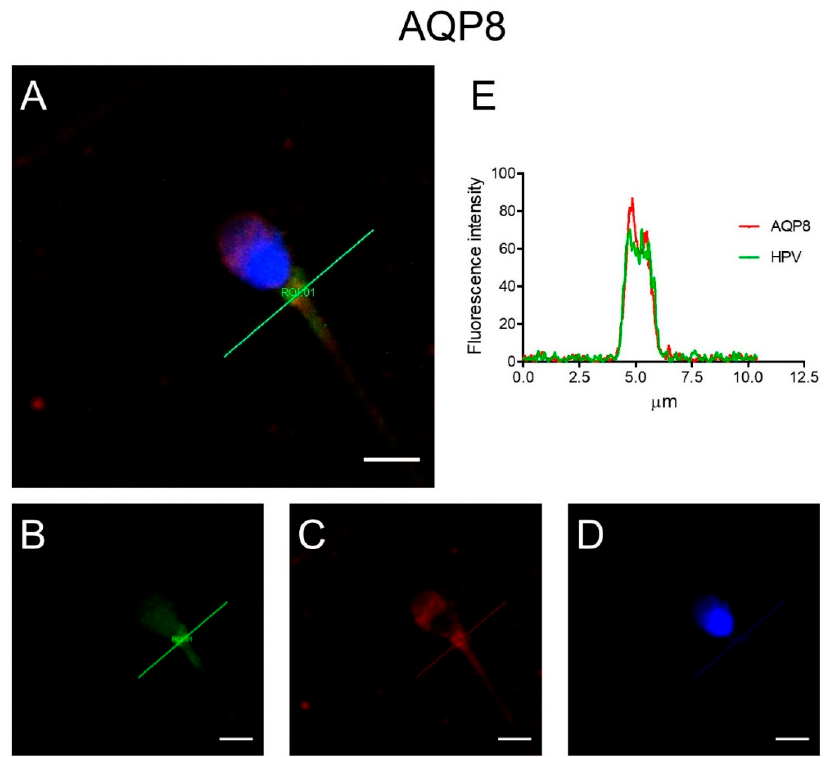
Figure 2. Representative immunofluorescence confocal microscopy images of colocalization of AQP8 and HPV in human sperm. ( A ) Green labeling indicates the presence of HPV, red labeling the expression of AQP8, while nuclei were counterstained by DAPI (blue). Yellow labeling shows colocalization signal of AQP8 with HPV. Scale bar, 5 μ m. ( B , C , D ) Images show single labeling for HPV (green; B ), AQP8 (red; C ) and nuclei (DAPI; D ). ( E ) Colocalization graphs, measured in the green line position in panel A, showing the overlap of the fluorescence signals originated by AQP8 and HPV